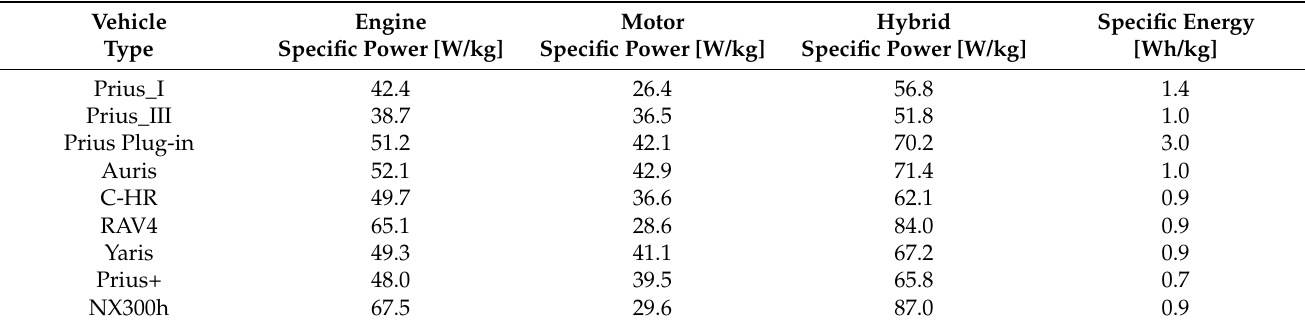
Table 2. Calculated indicators of the tested hybrid propulsion